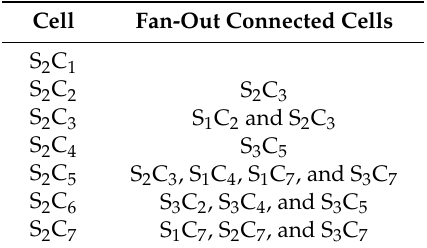
Table 2. Fan-out connected cells of example in Figure 7.